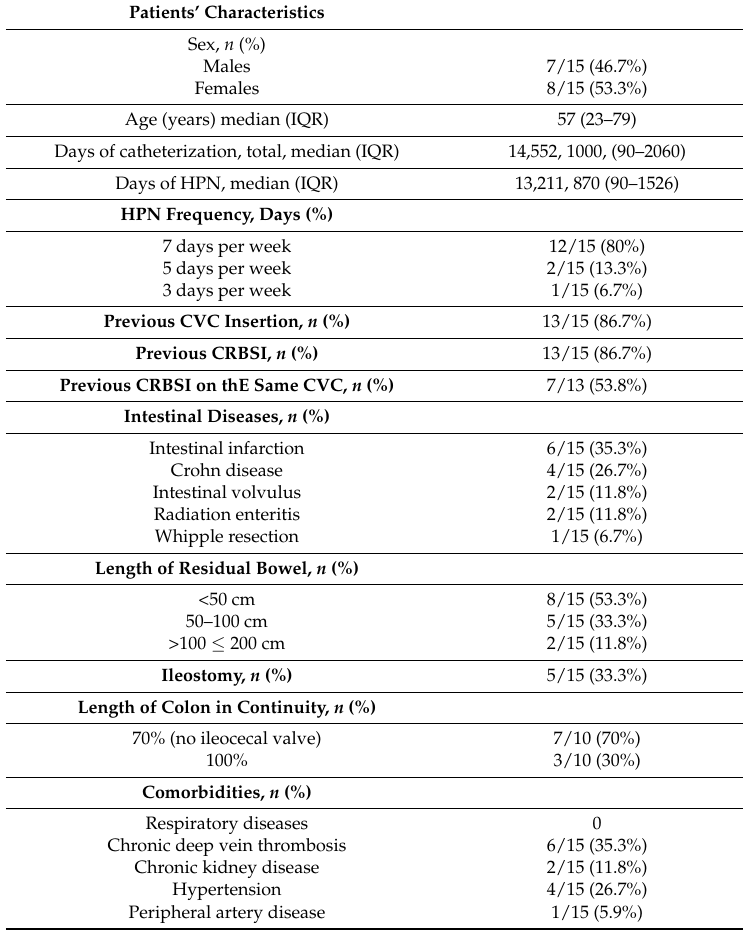
Table 1. Baseline characteristics of the 15 patients with one or more episodes of CRBSI (total infections =